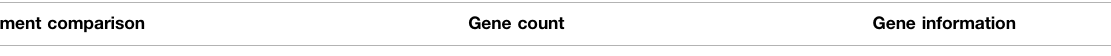
TABLE 3 | Screening of target genes. Treatment comparison Gene count Gene